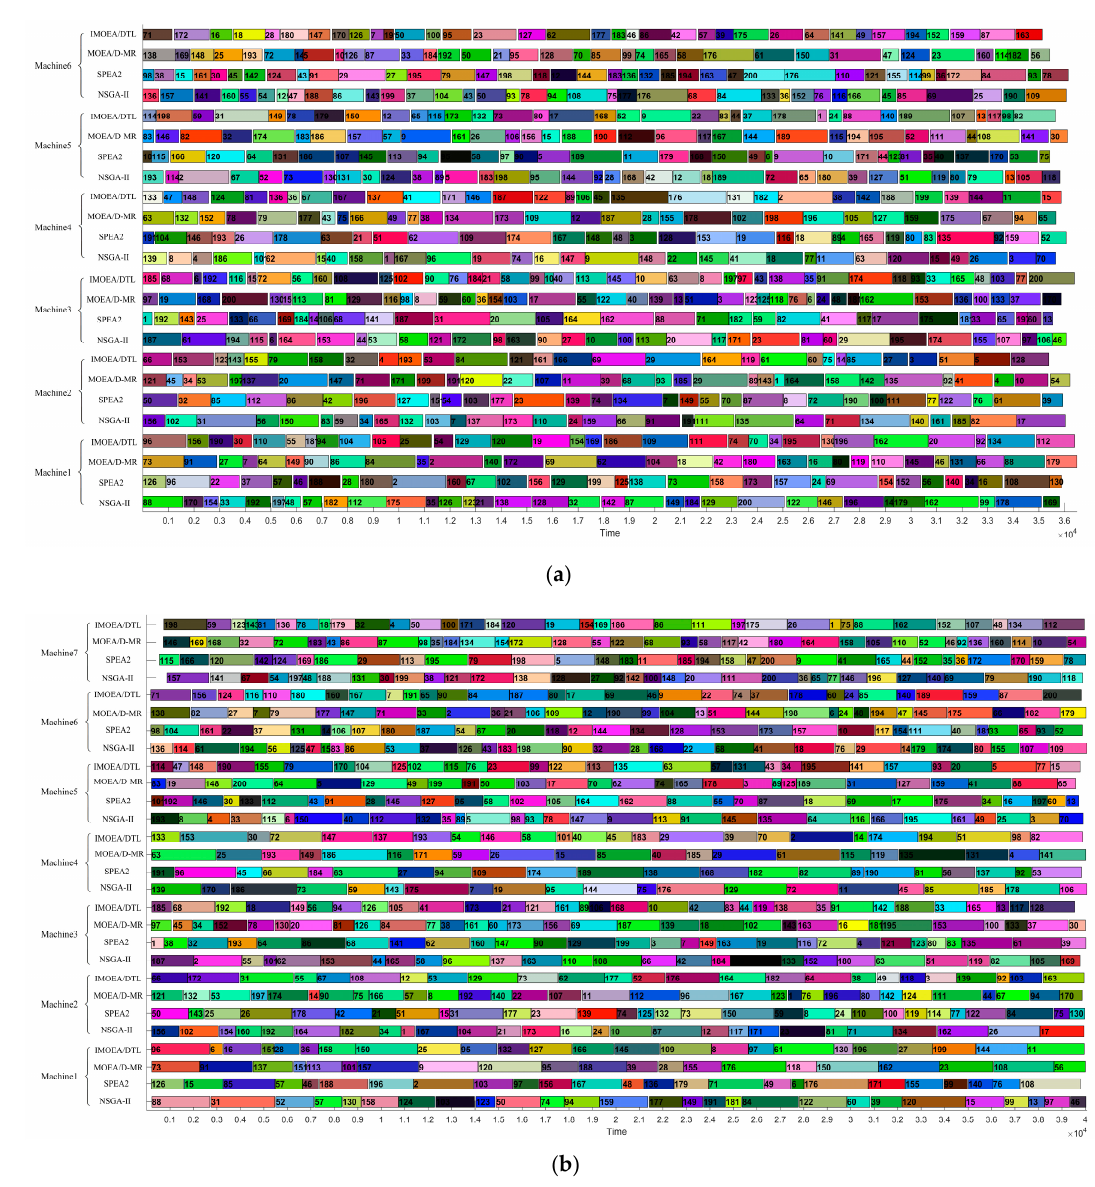
Figure 6. The Gantt charts of Job16, ( a , b ) are Gantt charts of the first and second operation of Job16 respectively; the makespan and energy cost of NSGA-II, SPEA2, MOEA/D-MR, and IMOEA/DTL are (4.0066× 10 4 , 3.3994× 10 6 ), (4.0020× 10 4 , 3.3900× 10 6 ), (4.0029× 10 4 , 3.4038× 10 6 ), and (3.9960× 10 4 , 3.3800× 10 6 ) respectively.